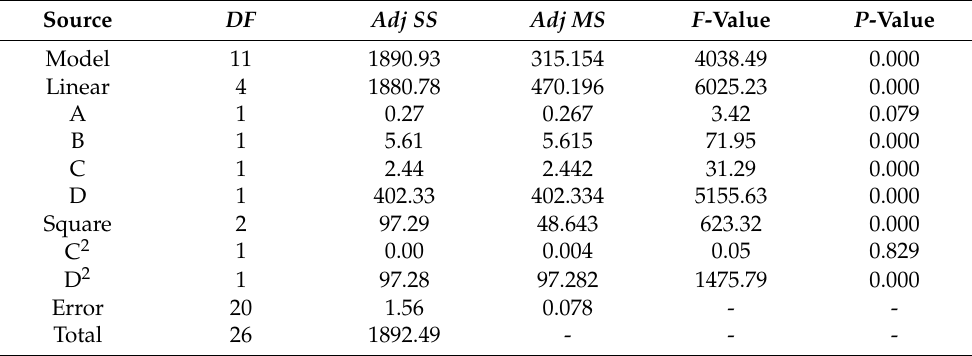
Table 7. ANOVA for the regression model using linearly squared